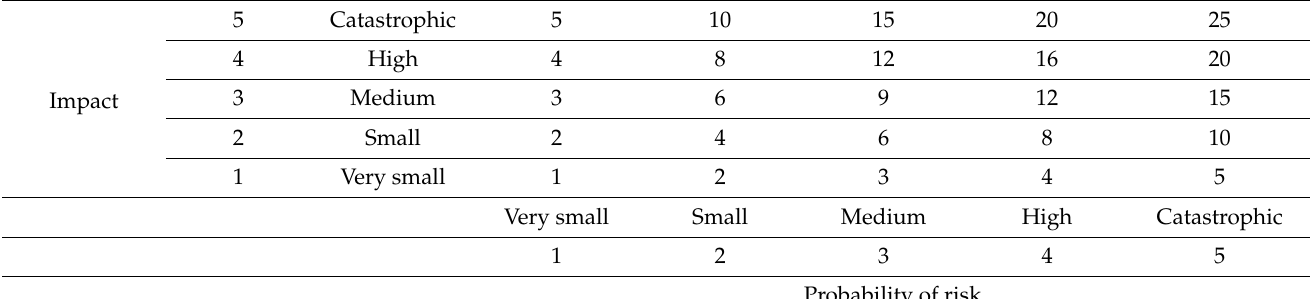
Table 1. Risk map with the probability of risk events’ occurrence and their impacts on a project.